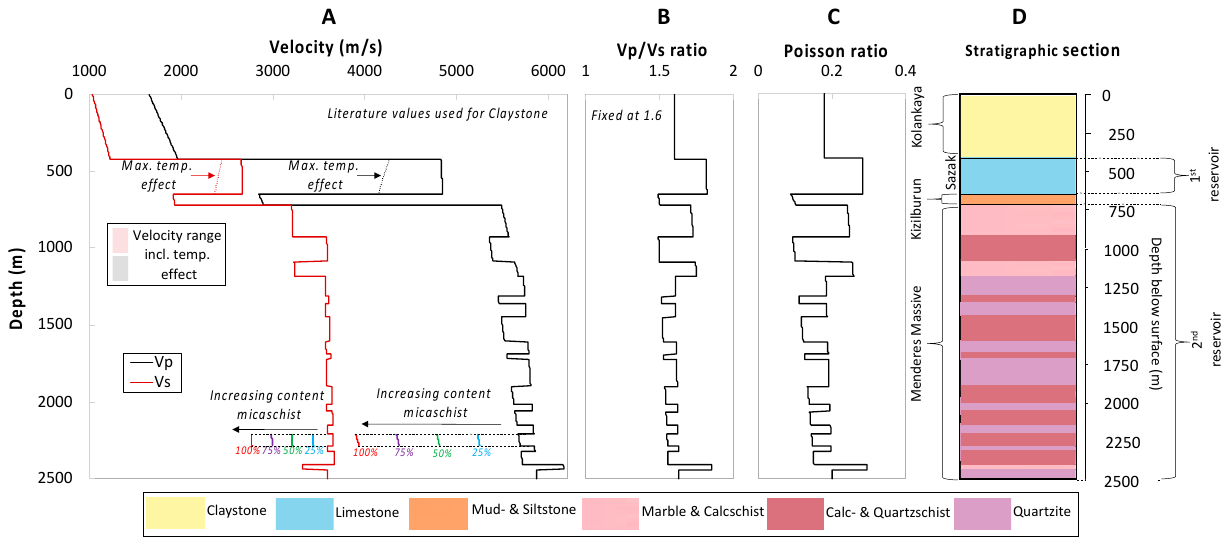
Figure 16. Seismic velocity profiles ( A ), P-wave/S-wave velocity ratio, i.e., Vp/Vs ( B ), Poisson ratio ( C ), and the stratigraphic section of interest ( D ). The stratigraphic section represents the planned CO 2 injection site at the Kızıldere geothermal reservoir. For the intervals that contain multiple rock types (mud- and siltstone, marble and calcschist, and calc- and quartzschist), a 50/50 distribution was assumed. Velocity–depth relationships, i.e., linear regressions, from Figure 8 (P-wave) and Figure S6 (S-wave) were used to construct the profile shown in ( A ). Since the claystone could not be assessed in this study, a literature value for its P-wave velocity, and for its Vp/Vs ratio, was assumed [67]. In one calc- and quartzschist layer, micaschists were added in varying degrees (25, 50, 75, and 100%) to show its effect on the resulting velocities. Note that the velocity profiles presented (black and red profiles in ( A )) reflect only the stress-dependency of the seismic velocities for dry conditions. In order to give an impression of the effect of temperature, on related velocities, the maximum temperature effect (dashed red and black profiles in ( A )) was added for the limestone interval. This represents the reduction in velocity with increasing temperature at atmospheric pressure (as presented in Figures 12 and S8). It is expected that the real dry velocity of the limestone interval in ( A ) lies somewhere in between the dashed and continuous lines, as it is assumed that the temperature-dependency is highest at atmospheric conditions, hence the ‘maximum temperature effect’.